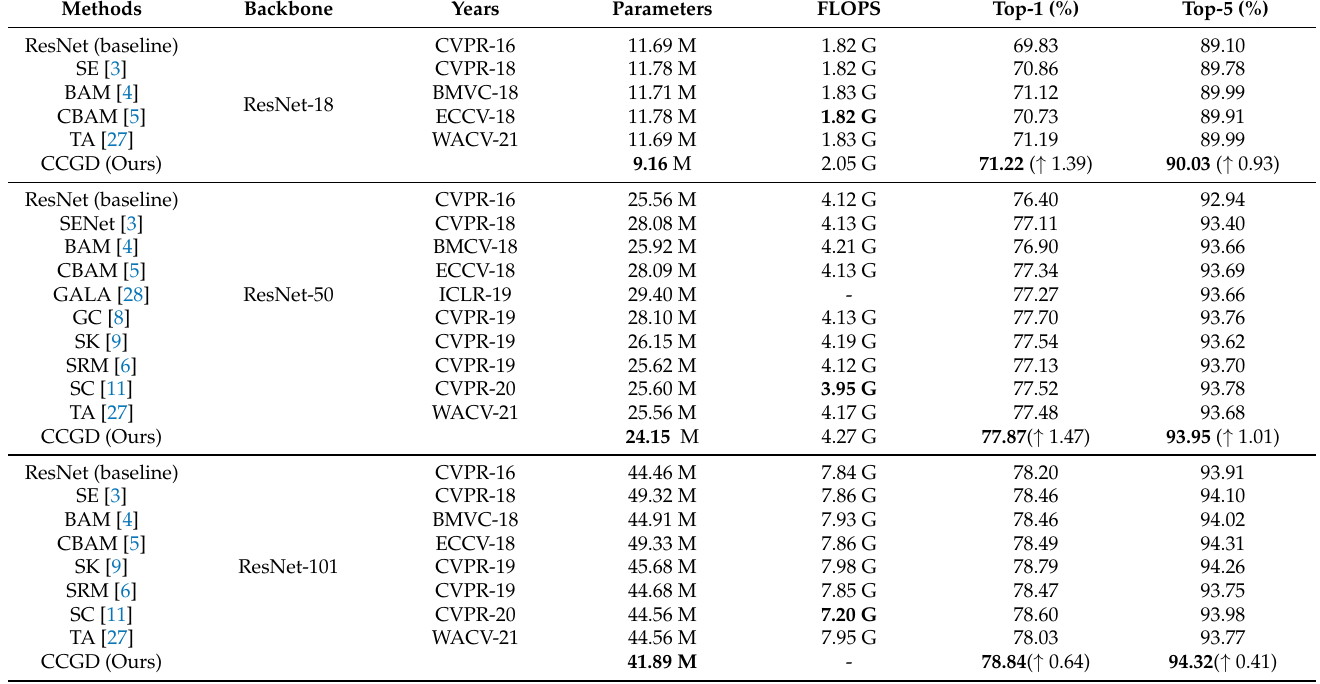
Table 3. The results of using different attention-based methods on ImageNet dataset with ResNet backbone. Results in bold are the best in each column with the same backbone. ↑ means the increase from